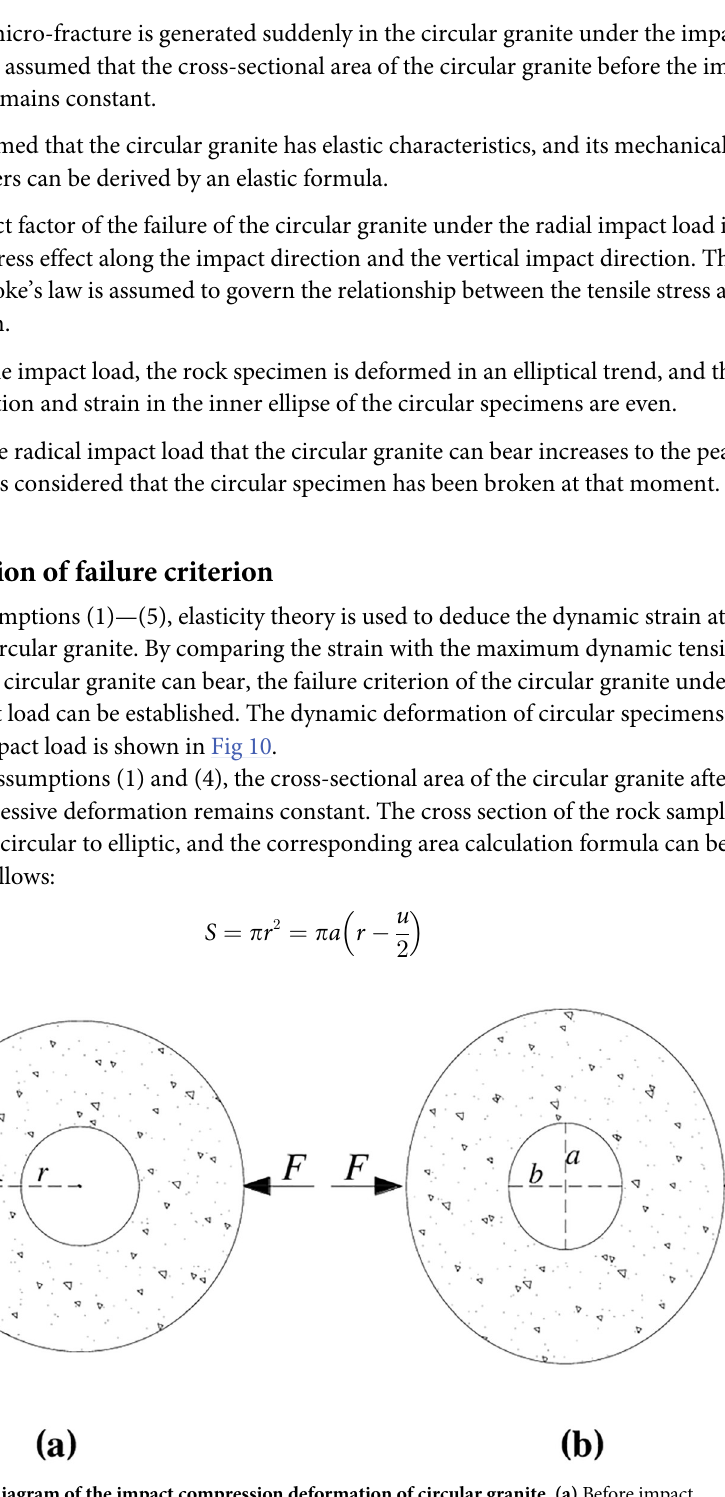
Fig 10. Schematic diagram of the impact compression deformation of circular granite. (a) Before impact deformation. (b) After impact deformation. (In the figure, F is the radial impact load, A is any point in the ring, r is the circle radius of the small circle inside the ring, and a and b are the long and short semi-axial lengths of the ring after deformation, respectively).